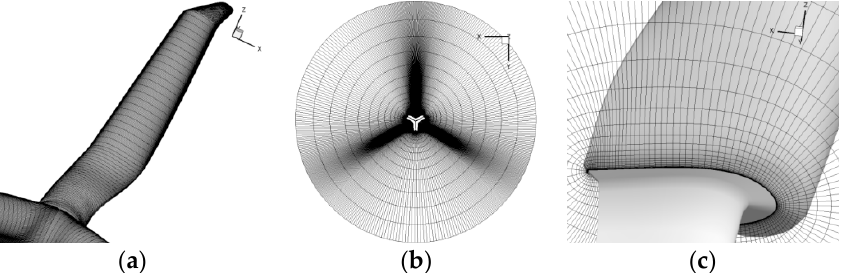
Figure 4. Mesh around the blades: ( a ) blade surface mesh; ( b ) mesh on a section away from the near-blade blocks; ( c ) mesh on an airfoil cross-section in the near-blade region. Table 1. The operational parameters.